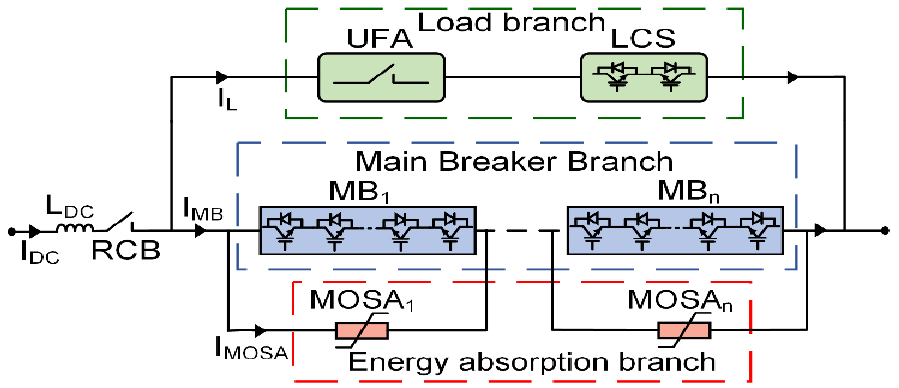
Figure 2. Schematic of H-DCCB as proposed by ABB.